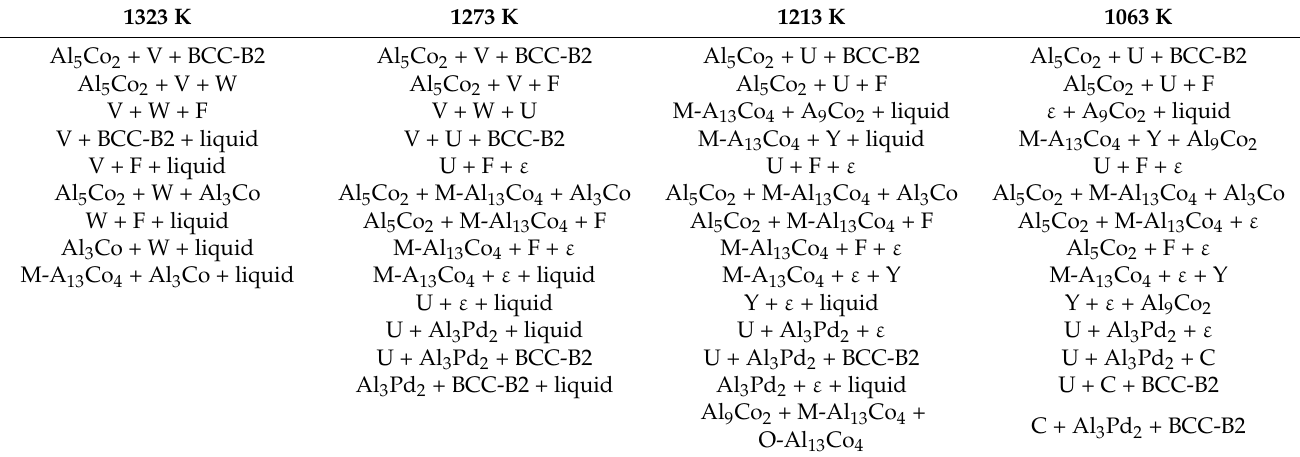
Table 2. Experimentally determined three-phase regions of the Al–Co–Pd system in the Al-rich corner of the phase diagram